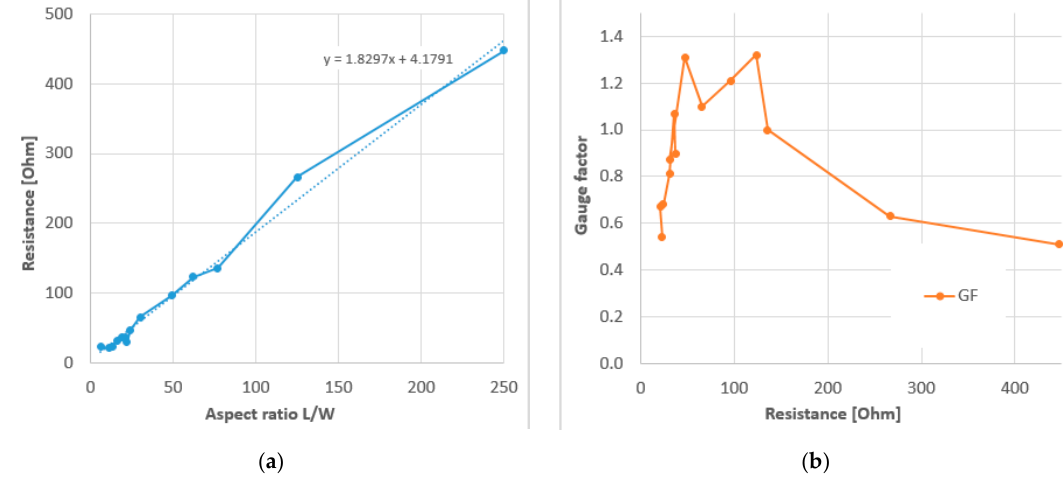
Figure 16. ( a ) Resistance and ( b ) gauge factor rectangular knitted sensors of different length and 6width; Based on [67].